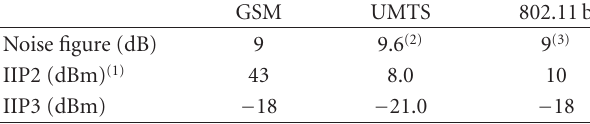
Figure 4: wCDMA receiver interference profile. Table 1: RF specifications for various standards.